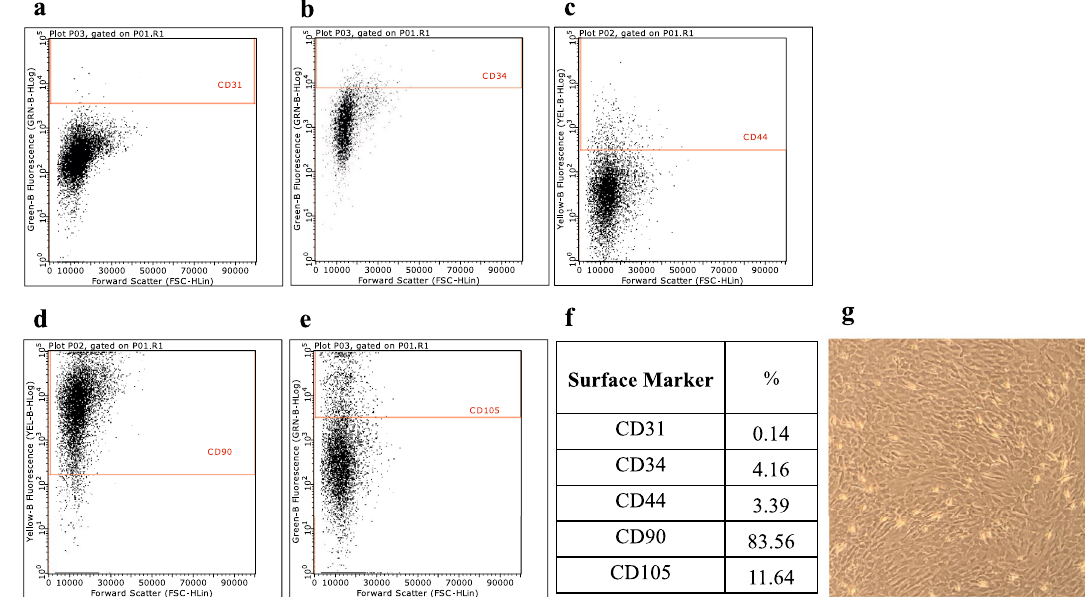
Figure 1. Flow cytometric analysis. ( a ‒ e ) Flow cytometric analysis after cell culturing. ( f ) Percentage of ADSCs in each sub-population. ( g ) Spindle-shaped cells were observed in the culture plate, a typical appearance of mesenchymal stem cells. ADSC adipose-derived mesenchymal stem